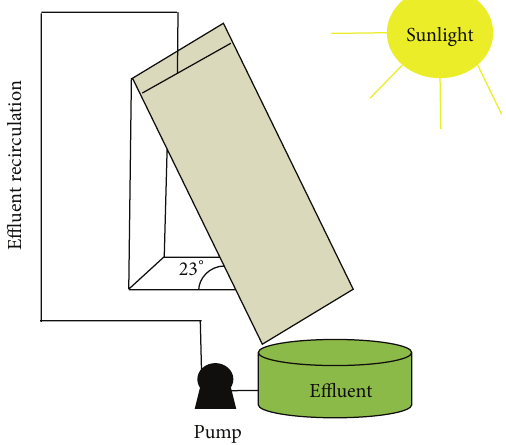
Figure 1: Schematic diagram of the solar reactor with ZnO photo- catalyst based on [8].